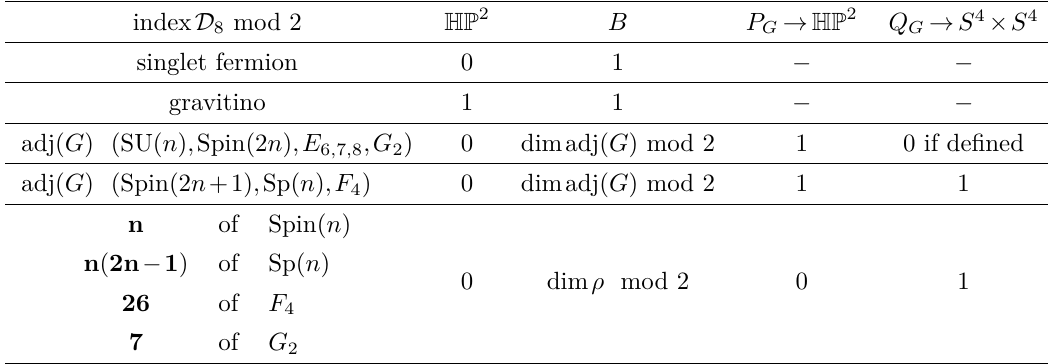
Table 1 . Index D 8 mod 2 on various manifolds for the fermion representations discussed in the main text. For Spin( n ) we only consider n ≥ 4 , and for Sp( n ) we only consider n ≥ 2